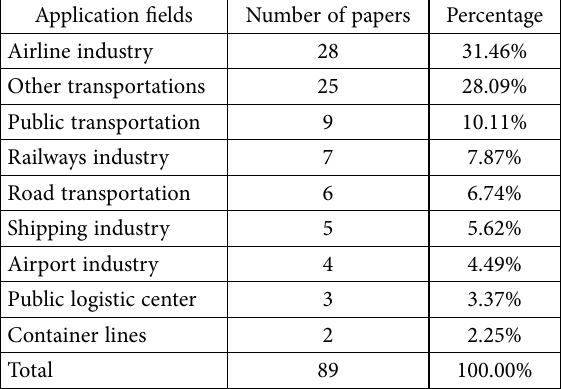
Table 2. Distribution papers based on transport